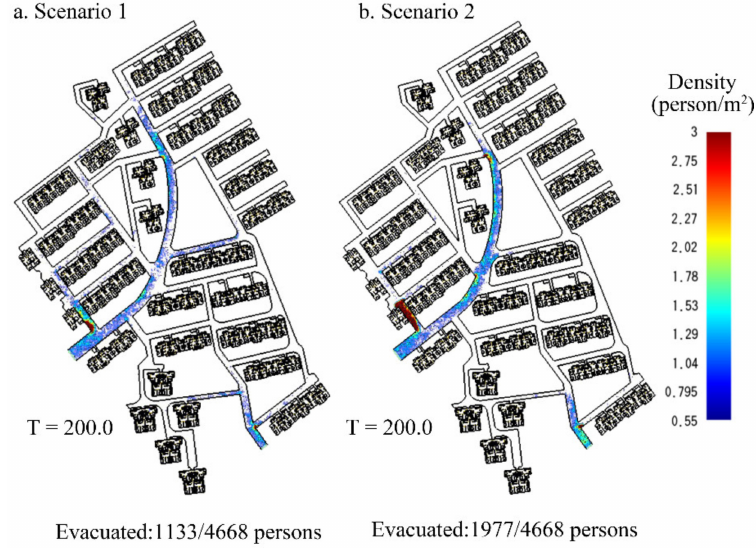
Figure 9. Crowd density of residents on roads in two scenarios. ( a ) Scenario 1: With pre-evacuation time. ( b ) Scenario 2: Without pre-evacuation